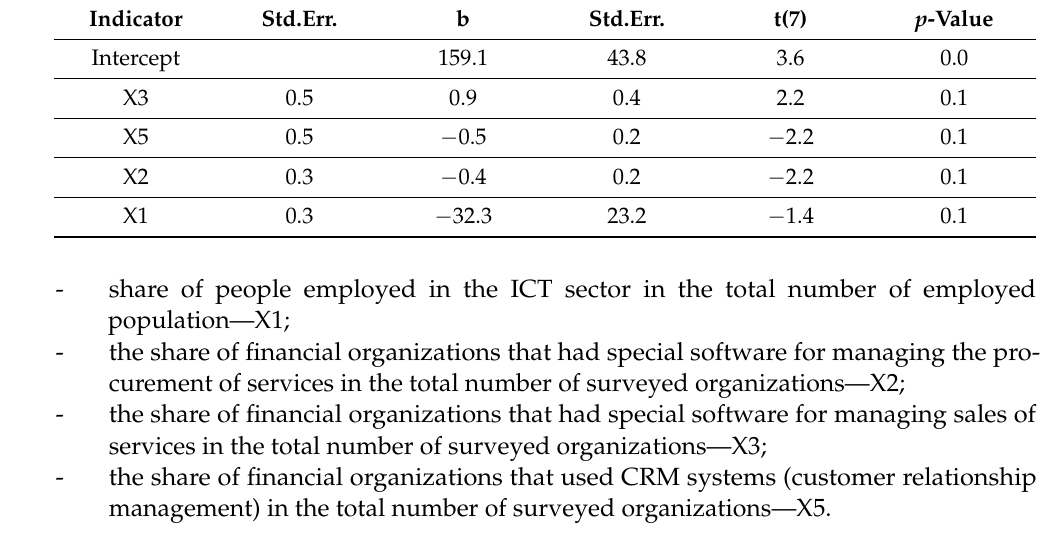
Table 4. Regression analysis results for variable Y2. Indicator